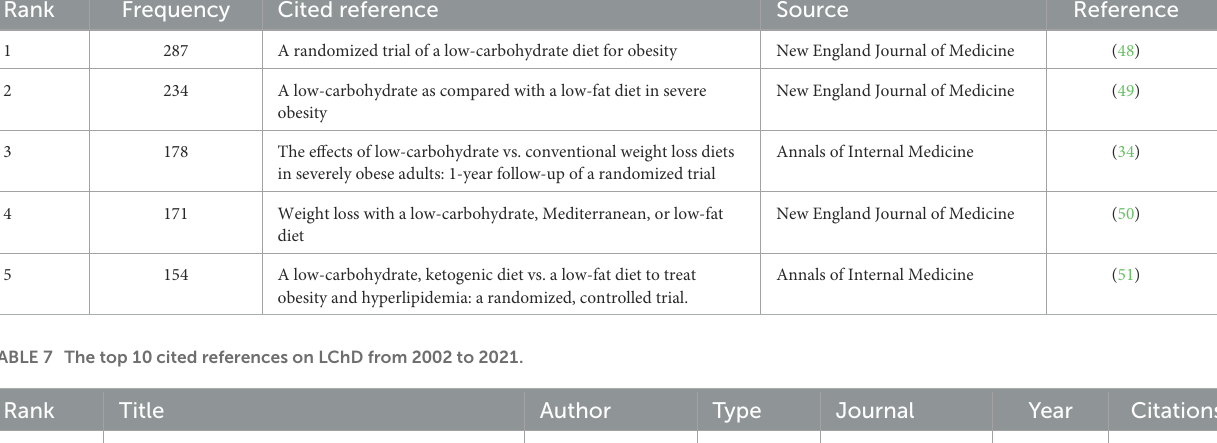
Comparison of the Atkins, Ornish, Weight watchers, and Zone diets for weight loss and heart disease